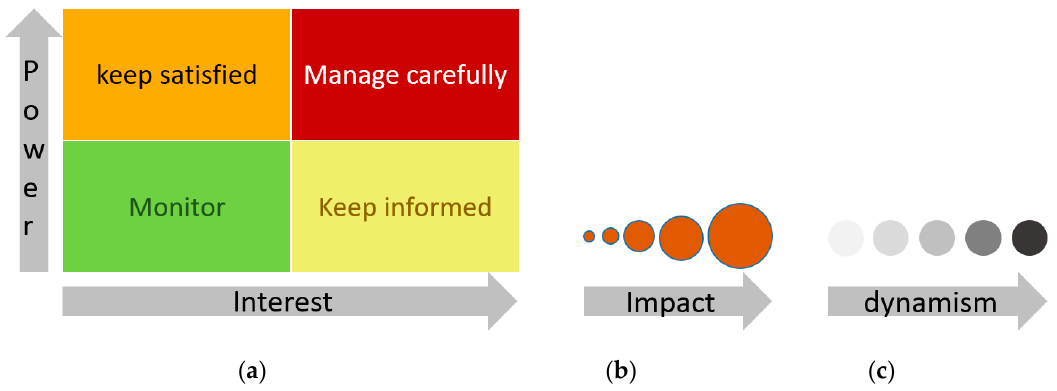
Figure 5. Symbols to be used to classify stakeholders: ( a ) variable power (vertical axis) and interest